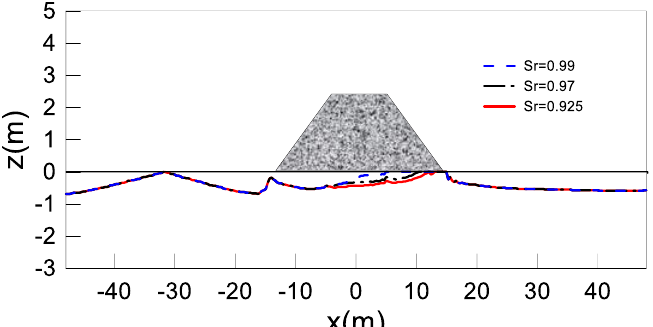
Figure 15. Development of liquefaction potential around the breakwater with various degrees of saturation.